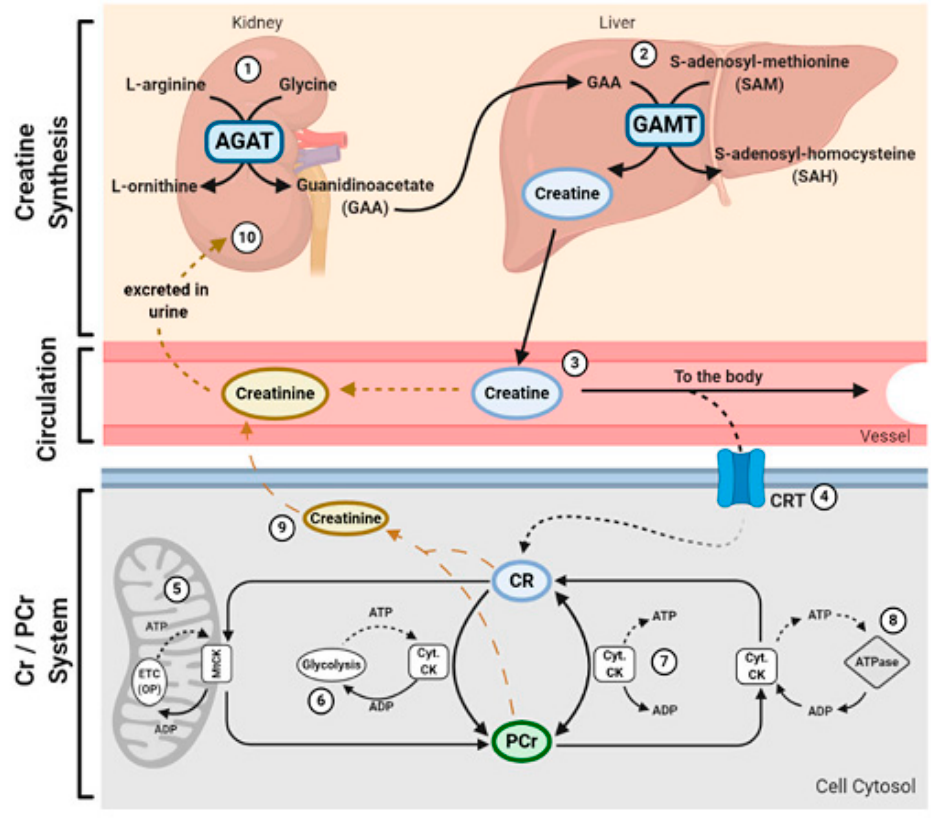
Figure 2. Physiological structure of creatine. Adopted from Clarke et al. [41]. L-arginine: glycine amidinotransferase (AGAT); anidinoacetate N-methyltransferase (GAMT); phosphocreatine (PCr); cytosolic creatine kinase (Cyt. CK); electron transport chain (ETC); adenosine diphosphate (ADP); mitochondrial creatine kinase (mtCK); and adenosine triphosphate (ATP).